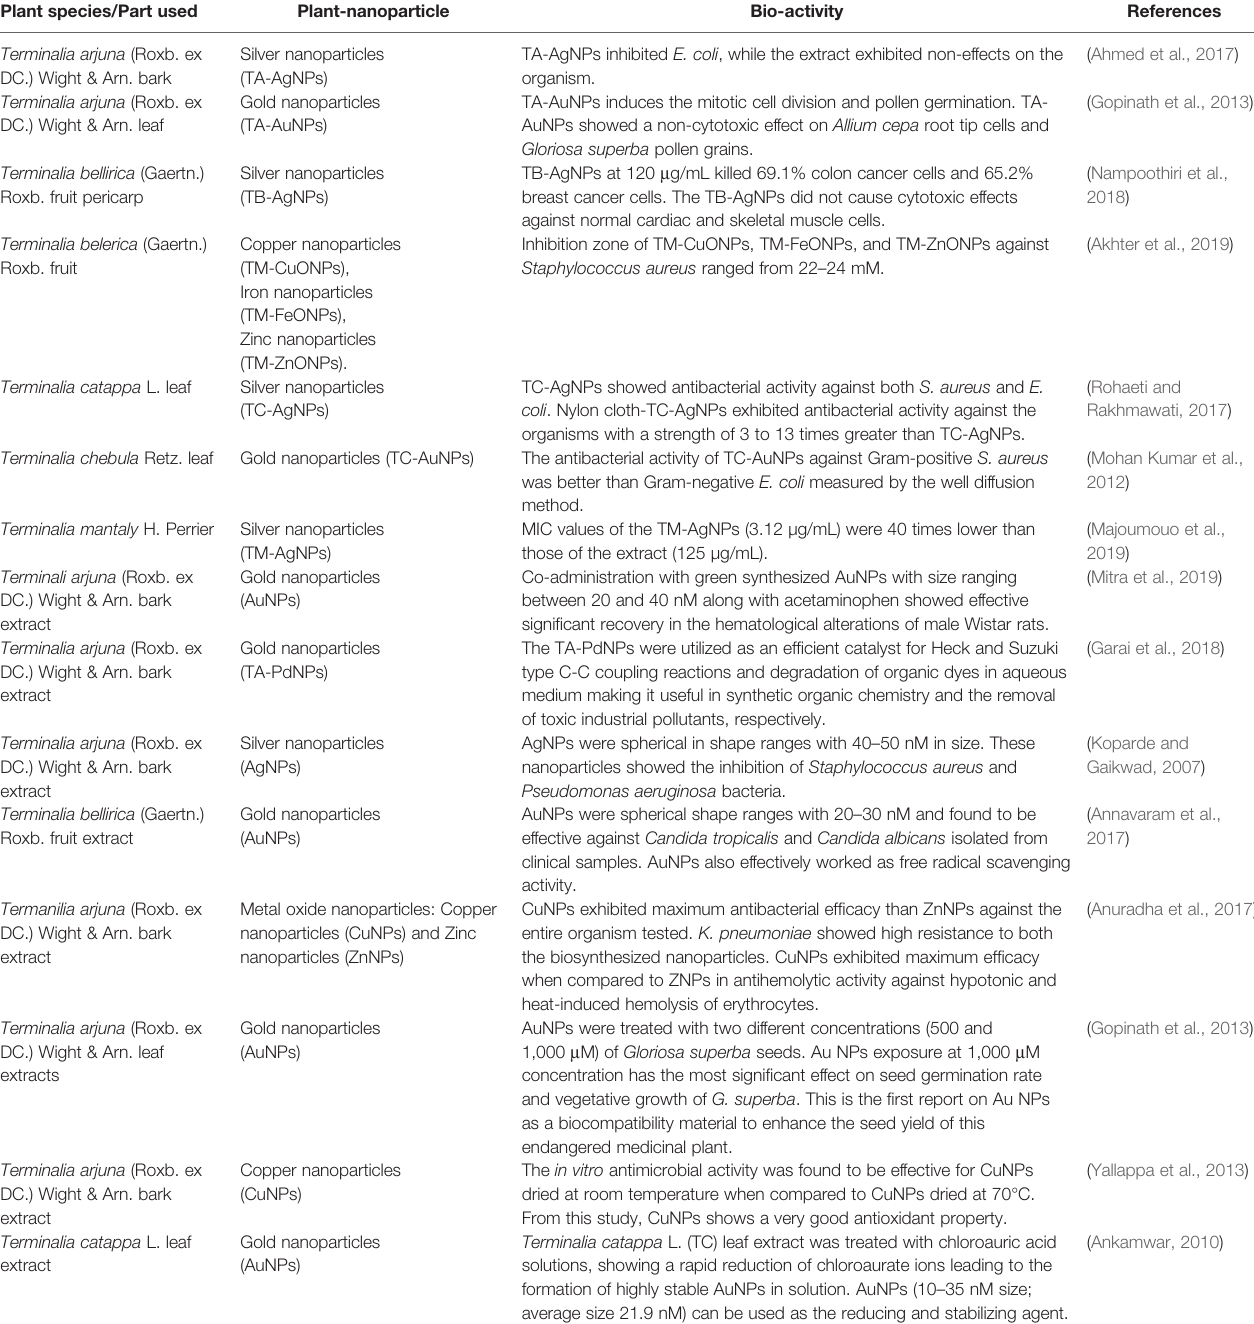
TABLE 10 | Bio-activity of nanoparticles synthesized using Terminalia sp.